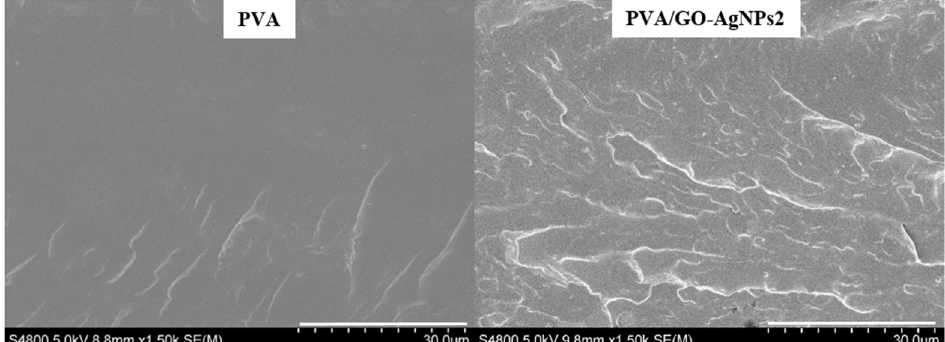
Figure 2. SEM images of the fracture surfaces of neat PVA and PVA/GO–AgNPs2 nanocomposite.